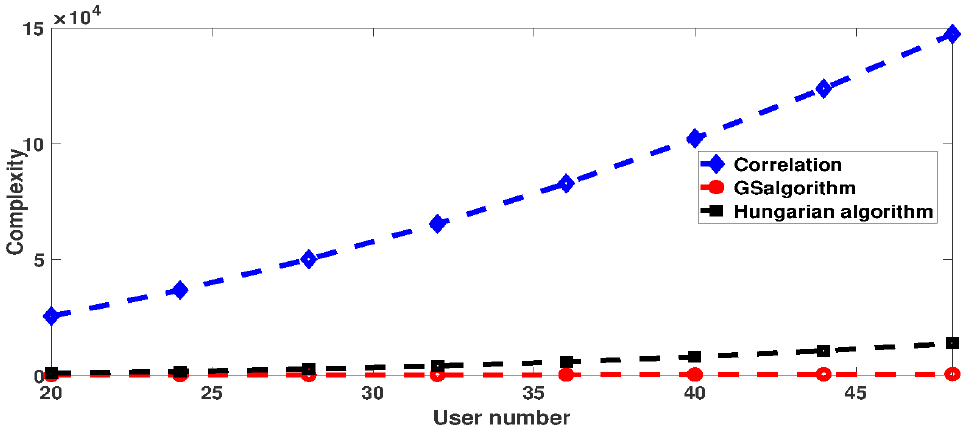
Figure 8. Complexity versus User number, with A = 64 BS